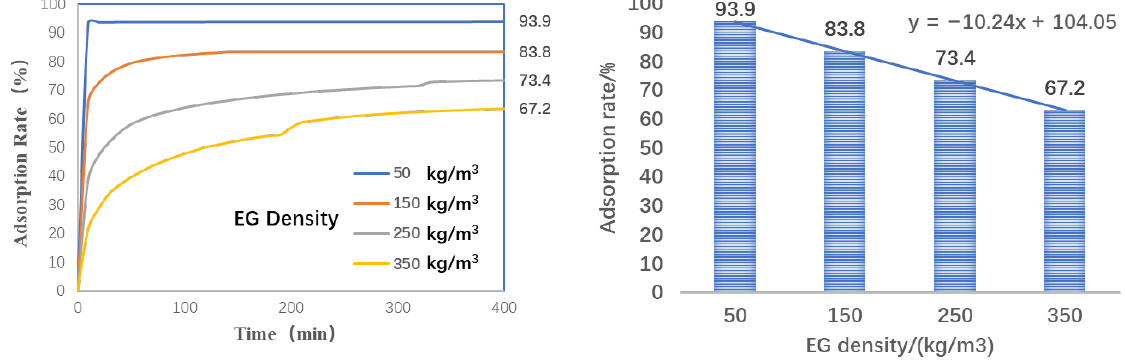
Figure 4. Adsorption rate of n-tetradecane in EG with different densities.